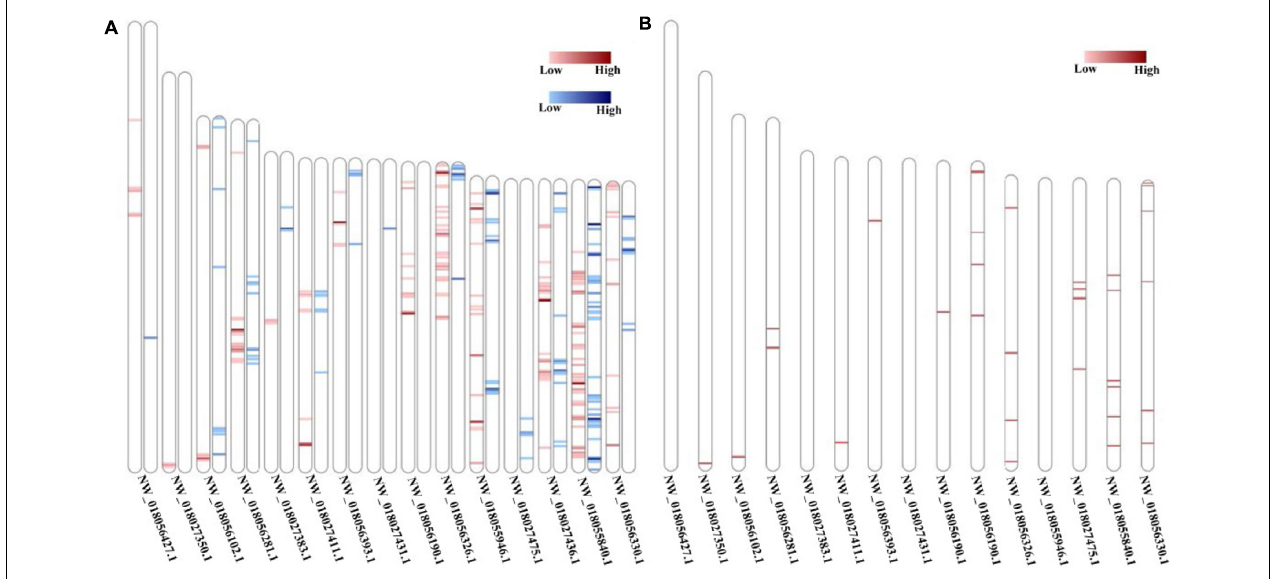
FIGURE 10 | The m5C (A) and m6A (B) methylation sites distribution of the 15 longest FL transcripts.